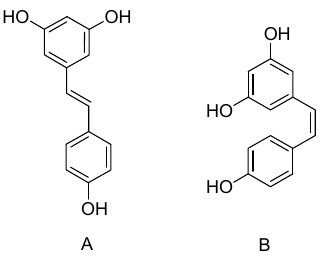
Figure 1. Chemical structures of trans ‐ resveratrol (3,5,4 ′‐ trihydroxystilbene) and its cis ‐ isomer. ( A ) trans ‐ resveratrol; ( B ) cis ‐ resveratrol.